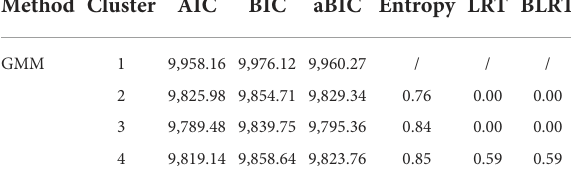
in Table 1. Across all models, entropy values ranged